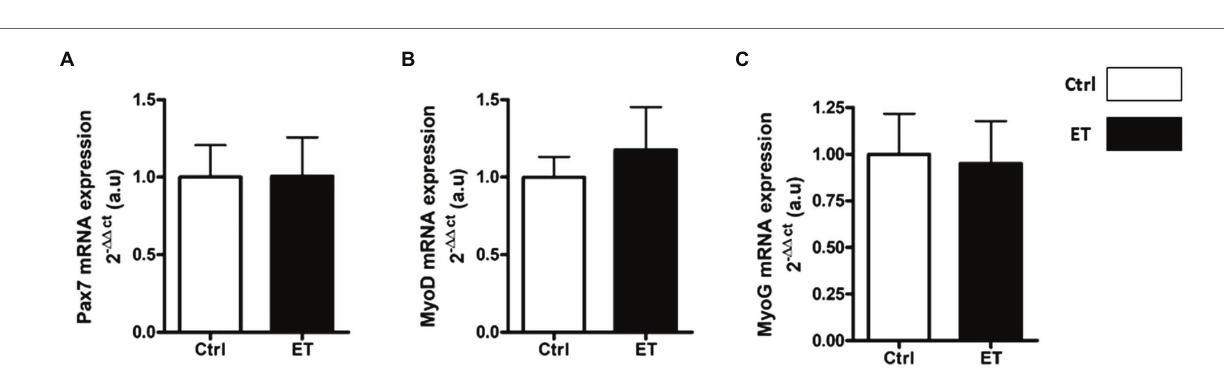
FIGURE 12 | Ergothioneine effect on satellite cell markers 2 h after exercise. Satellite cell markers in soleus and gastrocnemius samples. (A) PAX7 protein expression. (B) MyoD protein expression. (C) Myf-5 protein expression. (D) Myogenin protein expression. (E) Spry-1 protein expression. (F) Representative Western Blots; * p < 0.05; ** p < 0.01 vs. Ctrl.